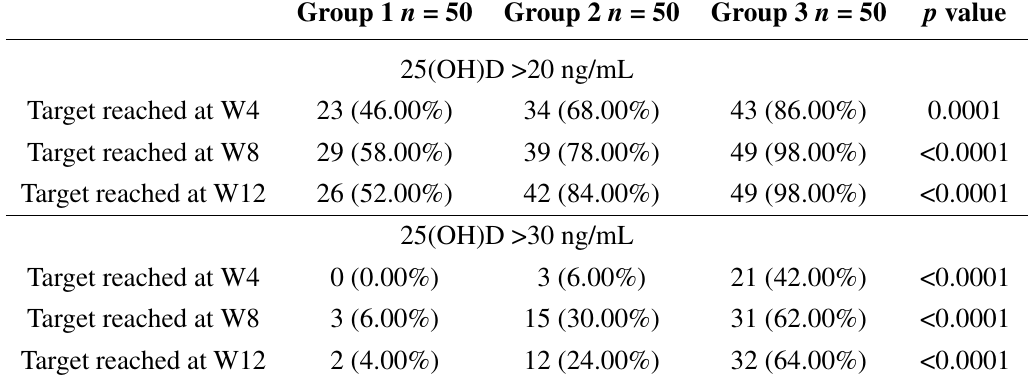
Table 5. Number (%) of subjects who reached the target levels of 20 ng/mL and 30 ng/mL at all time